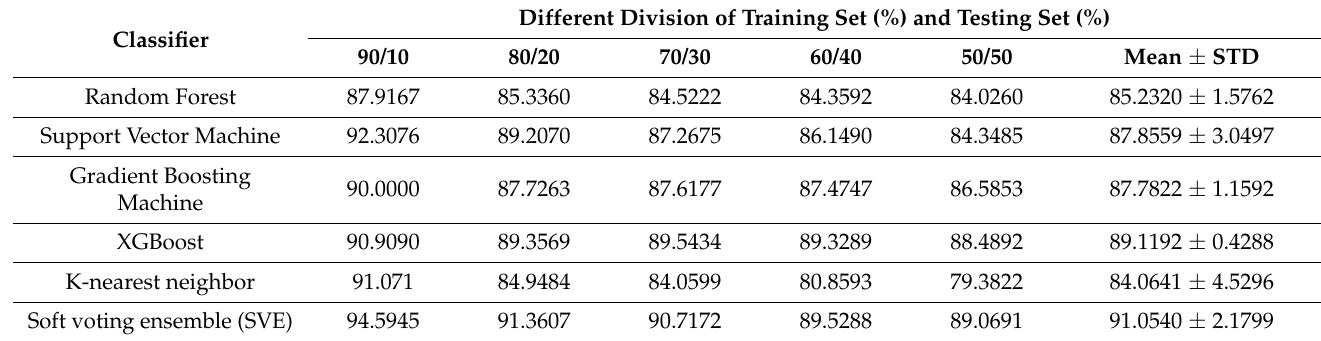
Table 7. Performance of all classifiers with recall (sensitivity) on different samples of training and testing splits. Different Division of Training Set (%) and Testing Set Classifier